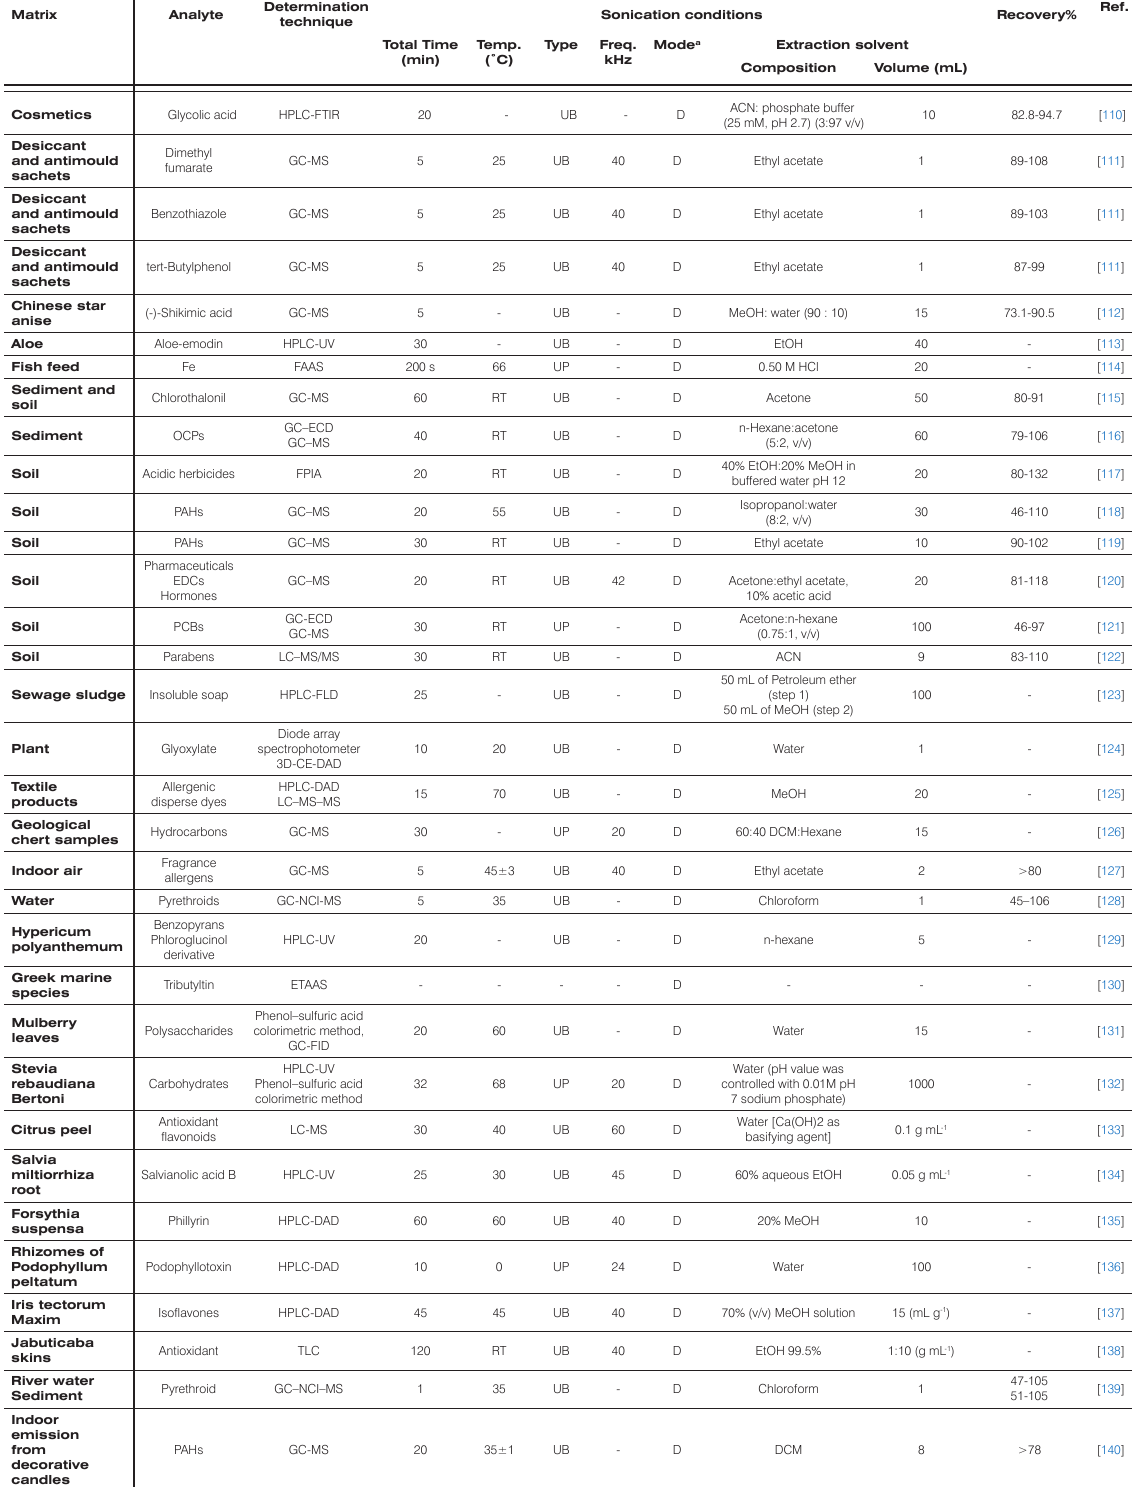
Table 4. Different ultrasound assisted extraction techniques for determination of organic and inorganic compounds from water, soil and plant